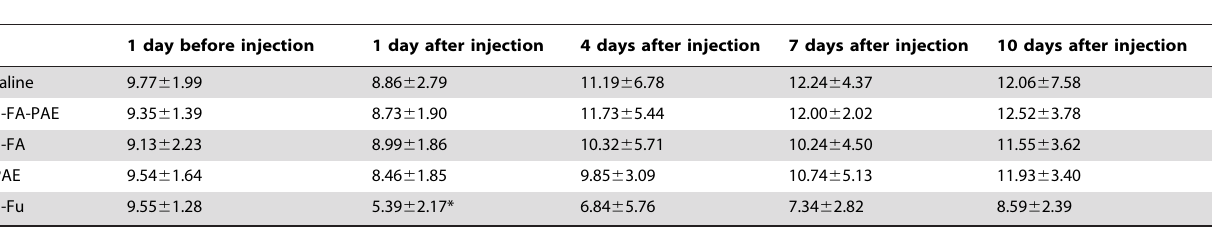
Table 2. The number of white blood cells in mice administered with saline, 5-Fu, 5-FA, PAE or 5-FA-PAE ( 6 10 9